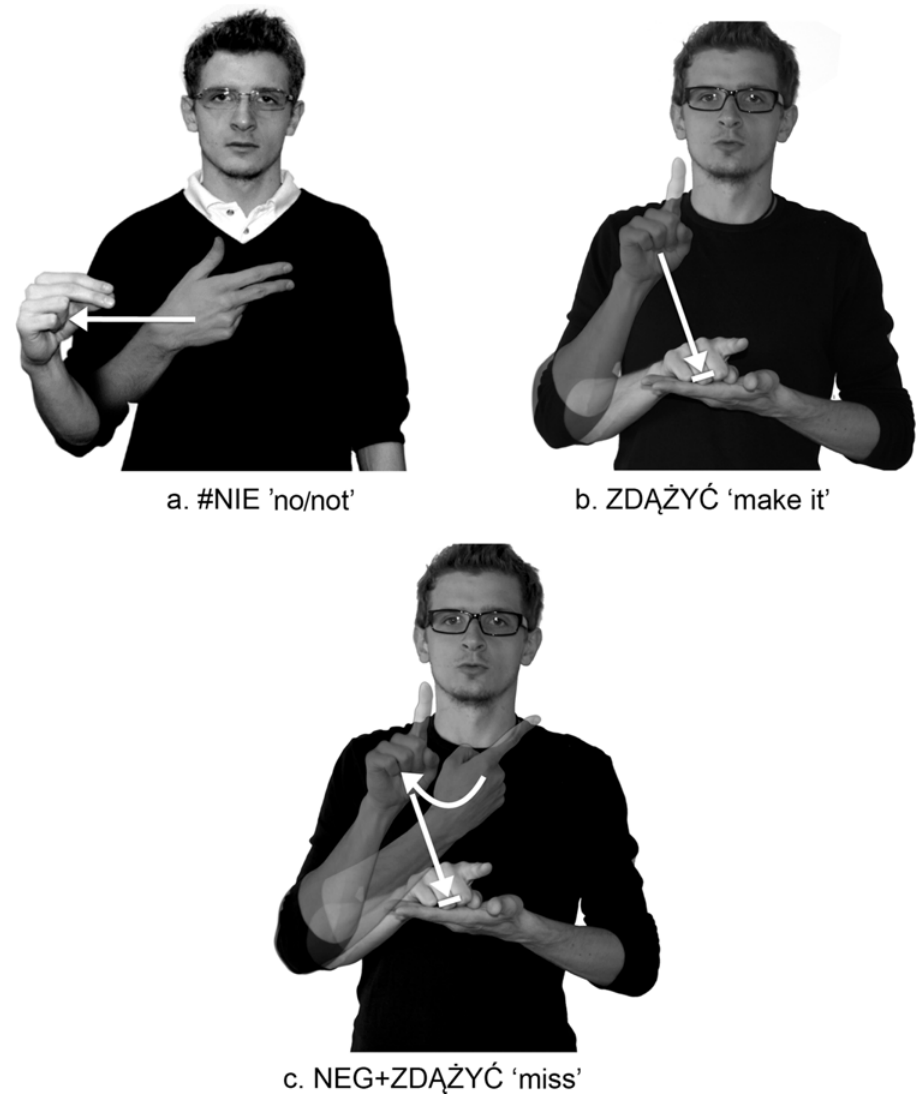
figure has given written informed consent (as outlined in PLOS consent form) to publish these case